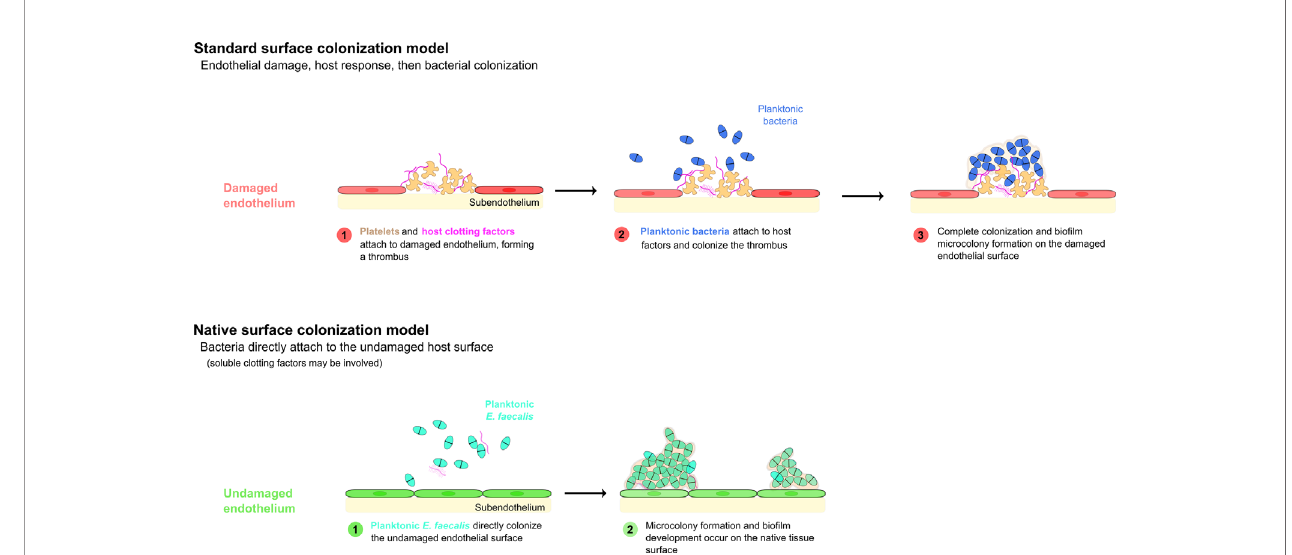
FIGURE 1 | Models of bacterial endovascular colonization. Canonical models of endovascular colonization typically involve an initial in fl ammatory event and/or cell surface damage, which leads to host factor recruitment, platelet aggregation, and fi nally bacterial colonization of the nascent thrombus. Recent research suggests that enterococci (among other bacterial species) can attach to the undamaged endothelial cells in some model systems without the involvement of signi fi cant host factors (adapted from Barnes et al.,